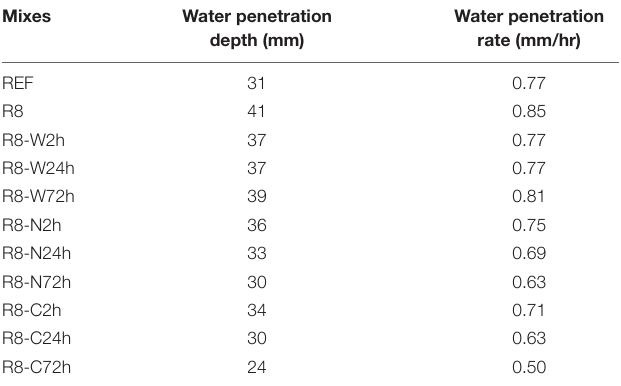
TABLE 3 | Water penetration depth and penetration rate of concrete samples.